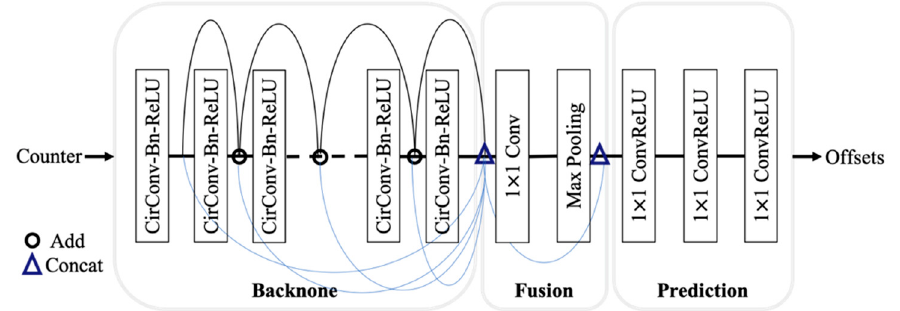
Figure 2. DeepSnake network architecture.